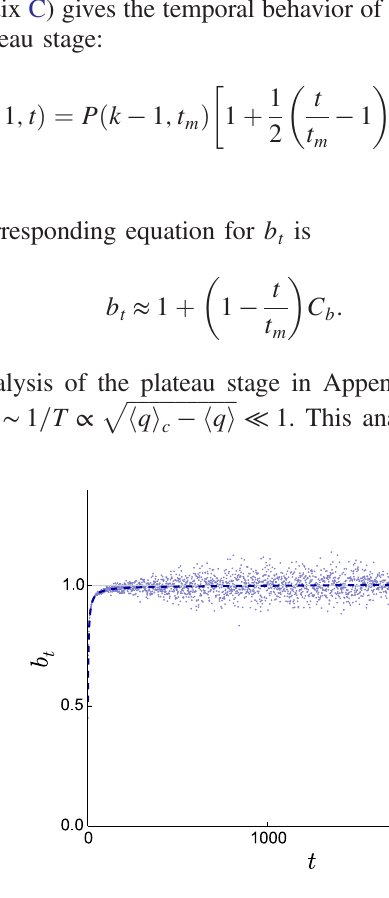
FIG. 8. Evolution of the mean branching ratio b t below (left) and above (right) the critical point for k ¼ 3 . Dashed curves are calculated using Eq. (10), points are from simulations. Parameters used and simulation realizations are the same as in Fig.